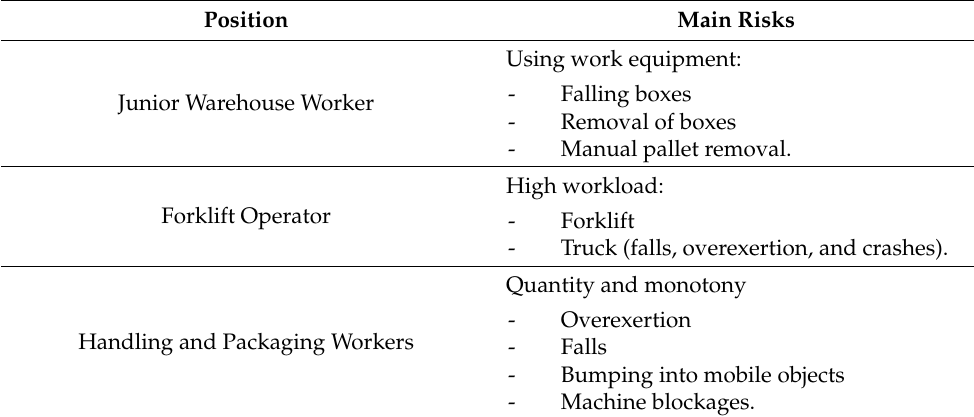
Table 6. Main position and risk